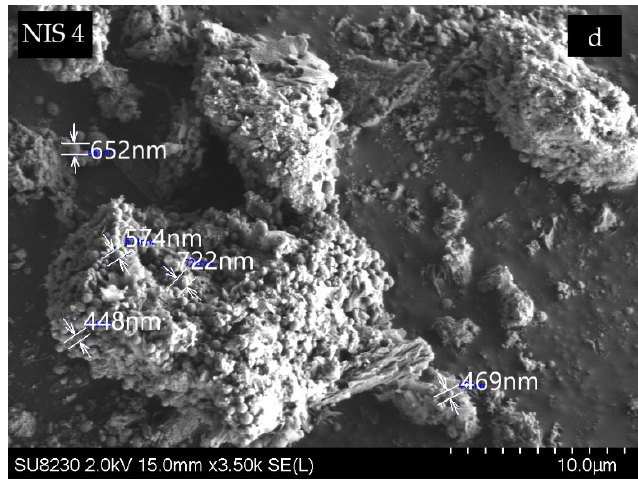
Figure 4. Scanning electron micrographs (SEM) for MIS4 and NIS4. ( a ) MIS4 at 350 magnifications. ( b ) NIS4 at 350 magnifications. ( c ) MIS4 at 20 000 magnifications. ( d ) NIS4 at 3 500 magnifications.